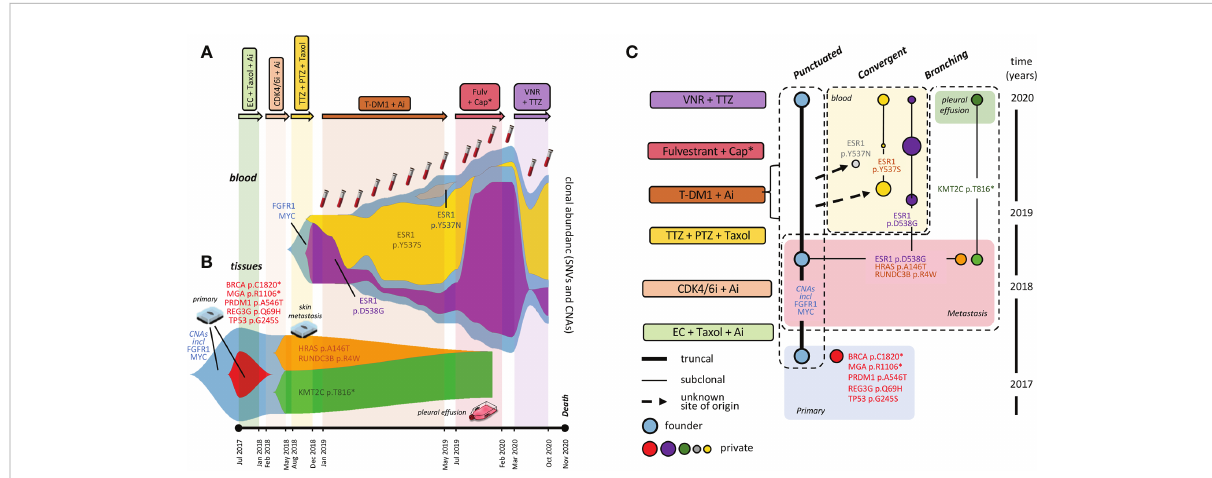
FIGURE 2 Fishplots and tumor phylogenesis. Fishplots displaying alterations in blood (A) and tumor lesions (B) . Areas are proportional to relative SNV abundances, whereas CNAs are depicted in background, not to scale. (C) Tumor phylogenetic tree: boxes surround evolution modes. Connecting lines: parental relationship proven (continuous) and inferred (dotted). ESR1 mutations: dimension of dots (blood variants) is roughly proportional to clonal representation. Tumor clones are consistently color-coded between fi shplot areas and the dots of the phylogenetic tree. Abbreviations as in Figure